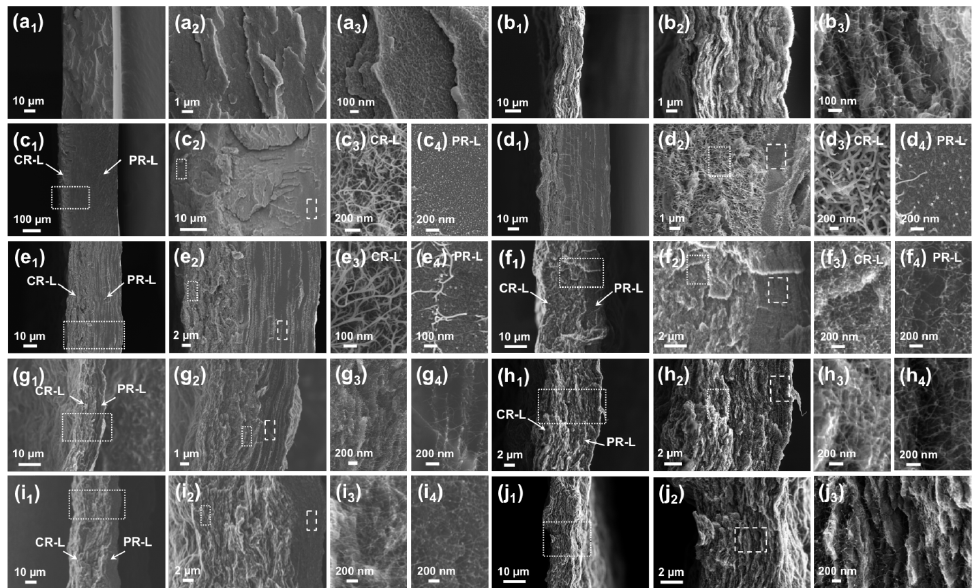
Figure 3. Scanning electron micrographs showing the cross-sections of neat PAN, SWNT-BP, and hPBP films. ( a ) PAN film, ( b ) SWNT-BP, ( c ) PAN:PT-12.5:1, ( d ) PAN:PT-5:1, ( e ) PAN:PT-2.5:1, ( f ) PAN:PT-1:1, ( g ) PAN:PT-0.67:1, ( h ) PAN:PT-0.5:1, ( i ) PAN:PT-0.25:1, and ( j ) PAN:PT-0.1:1. Magnified images of the PRL and CRL regions are also included.